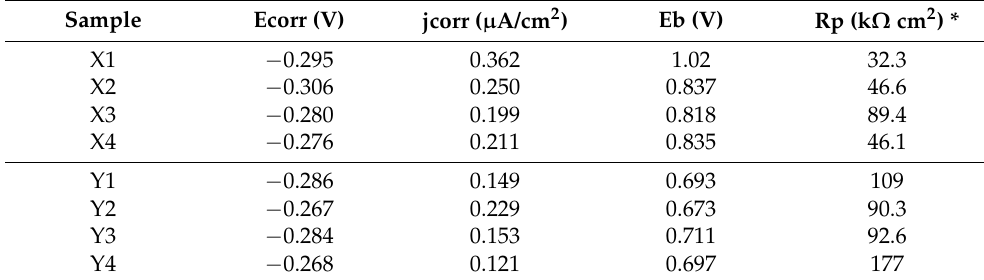
Figure 1. Potentiodynamic measurements for steel grade X (AISI 52100) ( a ) and steel grade Y (AISI D3) ( b ) in borate buffer pH 10 for conventional heat-treated samples (X1, X3, Y1 and Y3) and deep cryogenic heat-treated samples (X2, X4, Y2, Y4) at a scan rate 1 mV/s. Table 3. Electrochemical parameters, deduced from potentiodynamic curves and linear polarization